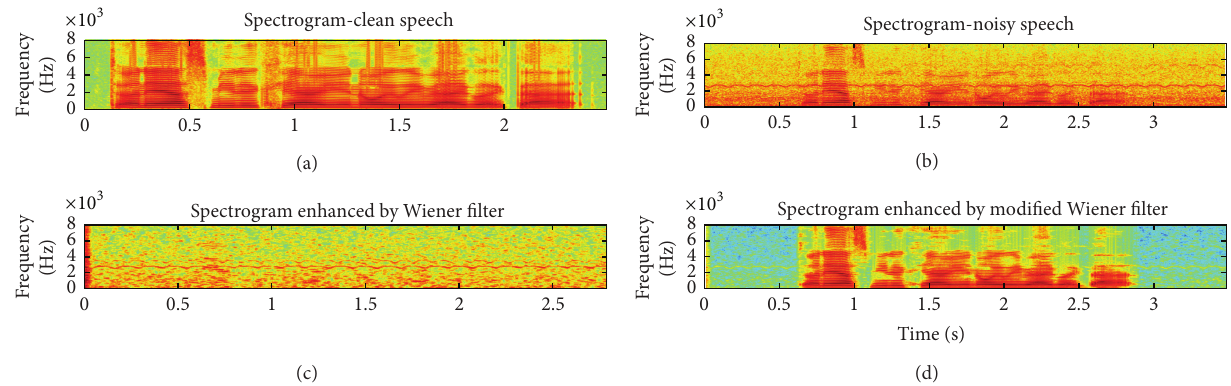
Figure 2: Speech spectrograms, buccaneer noise, 10dB. From (a) to (d), clean signal, noisy signal, enhanced signal by Wiener filter, and enhanced signal by modified Wiener filter.